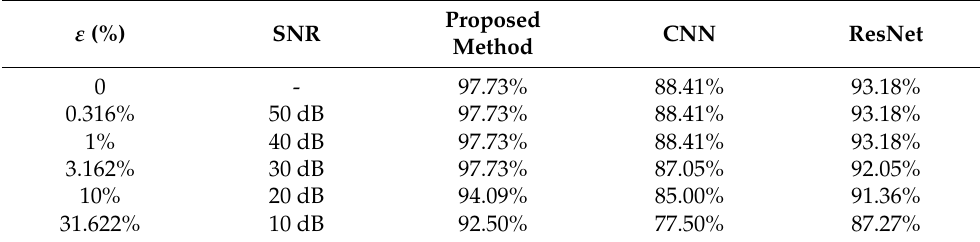
Table 6. Classification accuracy under different